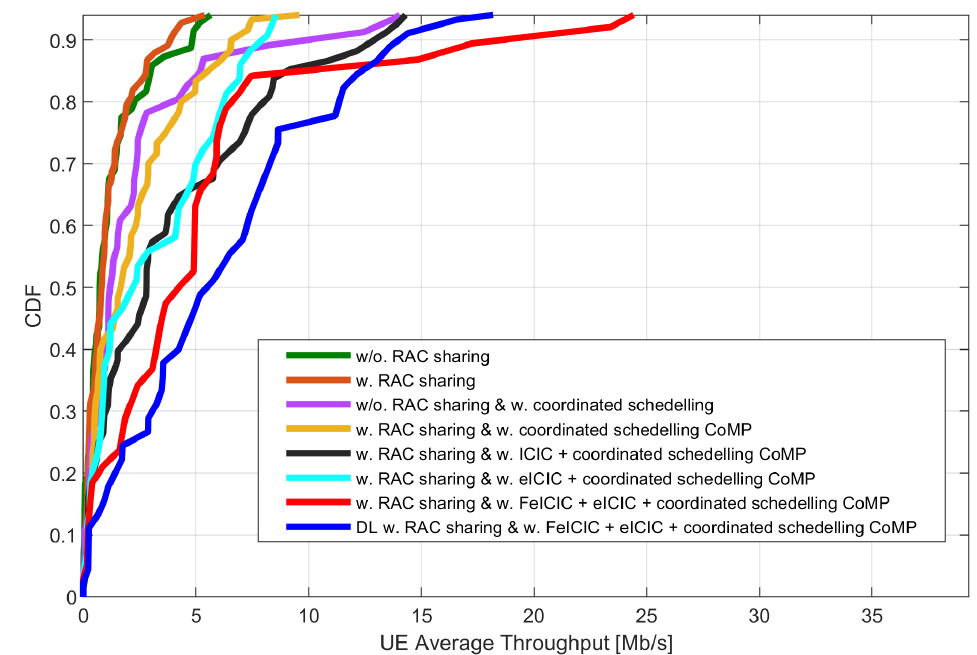
Figure 3. User’s average throughput vs.